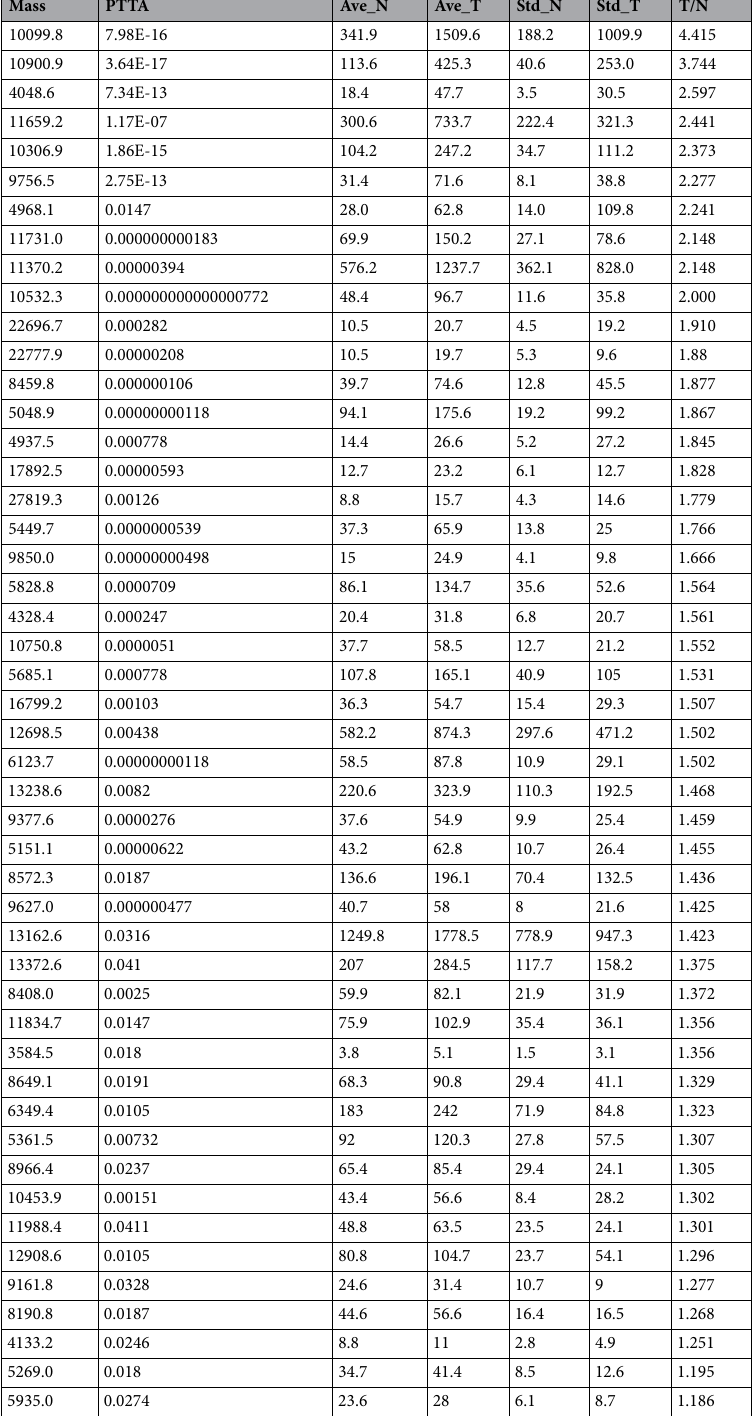
Table 1. Peak statistics (candidates listed with T/N > 1). T_Std: the mass standard deviation of tumor specimen, T_Ave: the averaged intensity of tumor specimen; N_Std: the mass standard deviation of normal tissue, N_Ave: the averaged intensity of normal tissue; PTTA: the P value of the t test/ANOVA of the individual peak; T/N: the ratio of